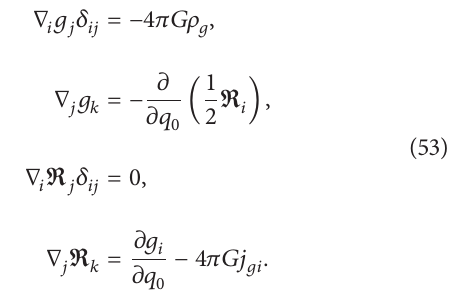
Figure 5: Magnetic field and spin period evolutionary tracks for ̇𝑀 = 10 18 g s −1 (solid line), different accretion rates: ̇𝑀 = 10 16 (dashed line), and gs −1 (dotted line), at fixed initial field = 5 × 10 12 G and period 𝑃 = 100 𝐵 0 0